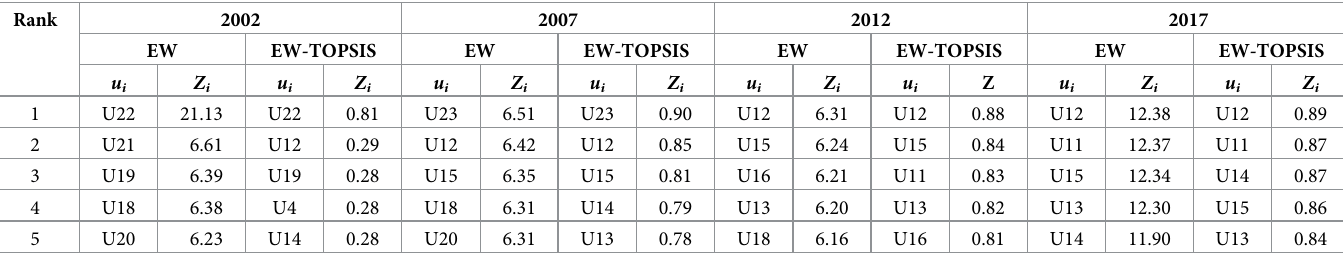
Table 7. Top 5 critical